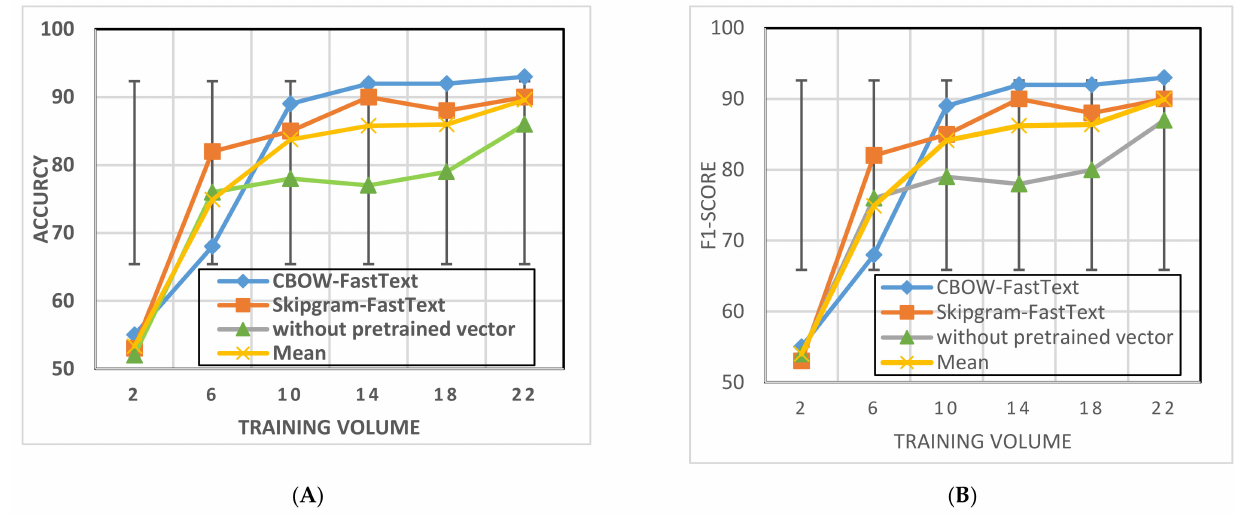
Figure 8. CNN results with FastText. ( A ) Accuracy; ( B ) F1 score.